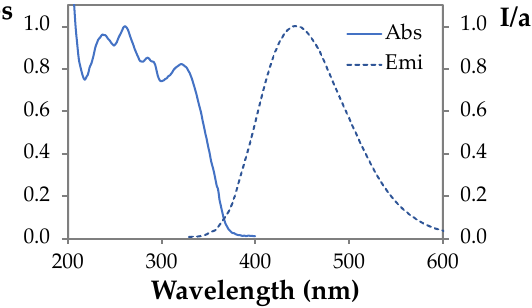
Figure 3. Normalized absorption and emission spectra of imidazole derivative 3 .